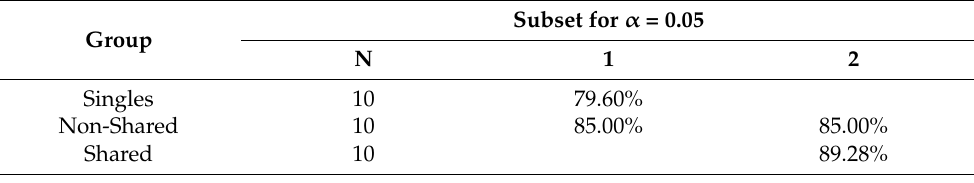
Table 3. Duncan’s test for difference between mean task performances in